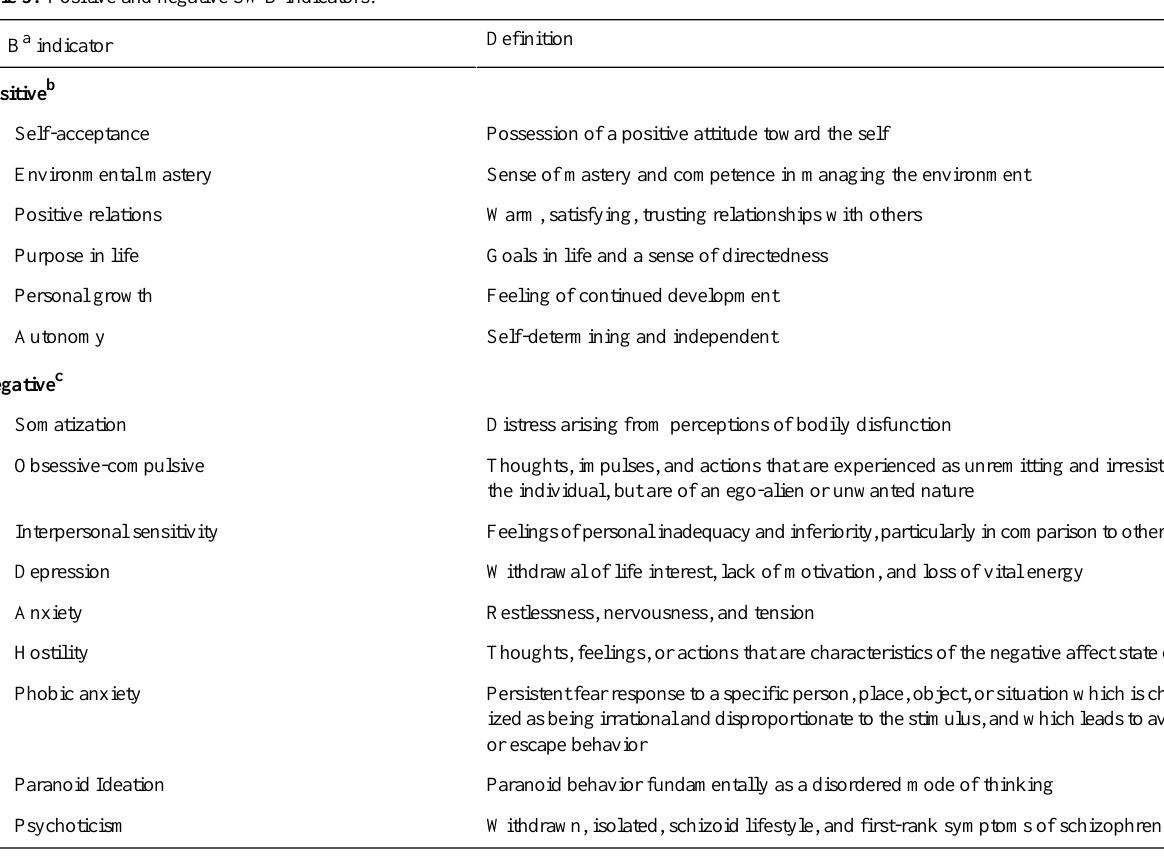
Table 3. Positive and negative SWB